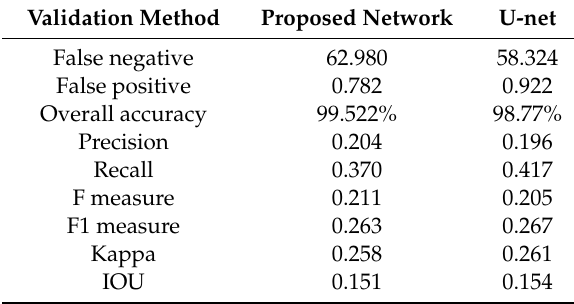
Table 7. Accuracy of the model in the Hanoi area.